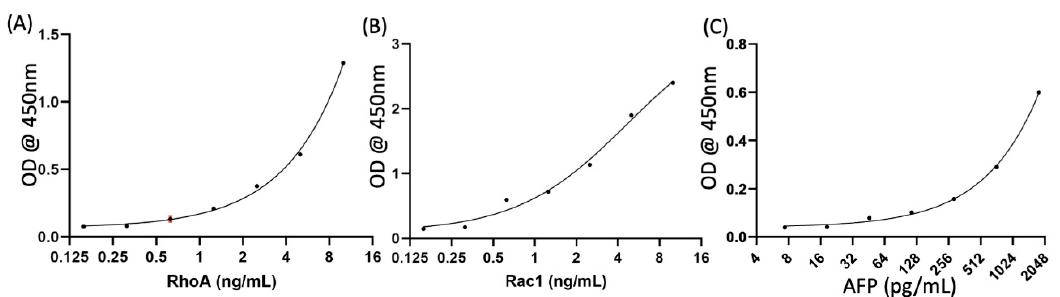
Figure A1. ( A ) The standard curve for the quantification of RhoA (R. sq. 0.996). ( B ) The standard curve for quantification of Rac1 (R. sq. 0.990). ( C ) The standard curve for quantification of AFP (R. sq. 0.998).